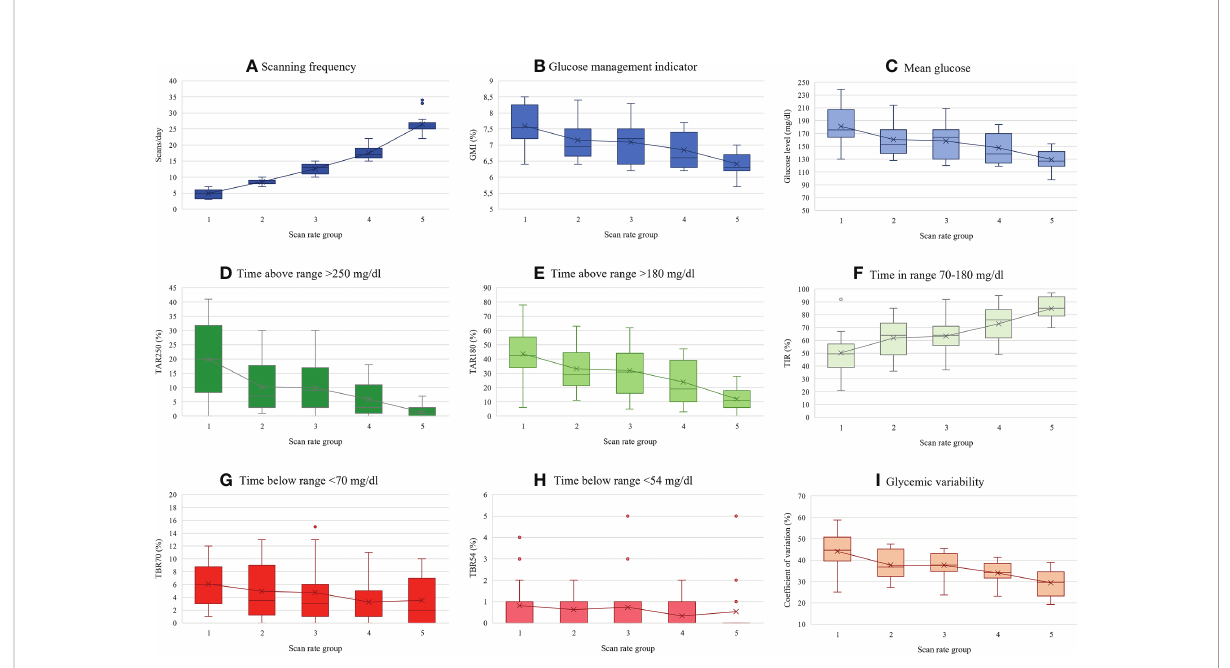
FIGURE 1 Glycemic indices across scan rate groups (each group represents 20% of subjects ( fi rst 2 groups – n=16, next 3 groups – n=15). (A) Scanning frequency, (B) Glucose management indicator, (C) Mean glucose, (D) Time above range >250 mg/dl, (E) Time above range >180 mg/dl, (F) Time in range 70-180 mg/dl, (G) Time below range <70 mg/dl, (H) Time below range <54 mg/dl, (I) Glycemic variability expressed as coef fi cient of variation. Data shown as mean and interquartile range.